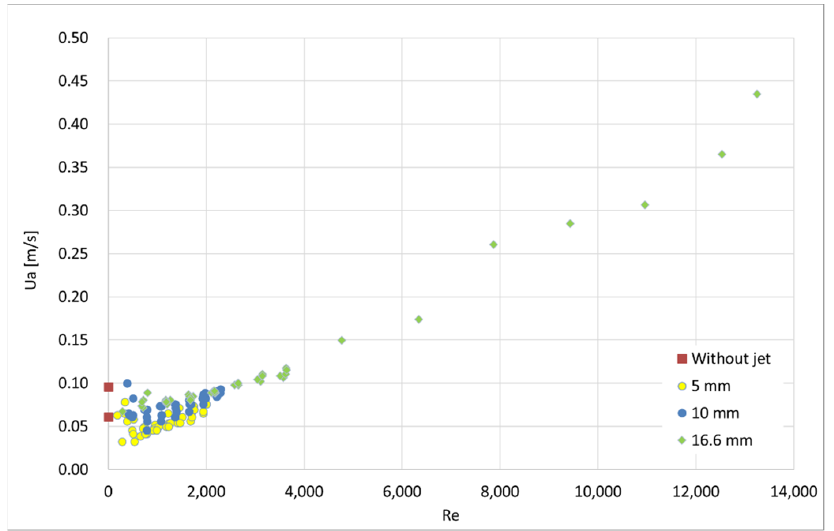
Figure 9. Test results for visual aerodynamic sealing of the air curtain (nozzle thickness and plane jet angle).